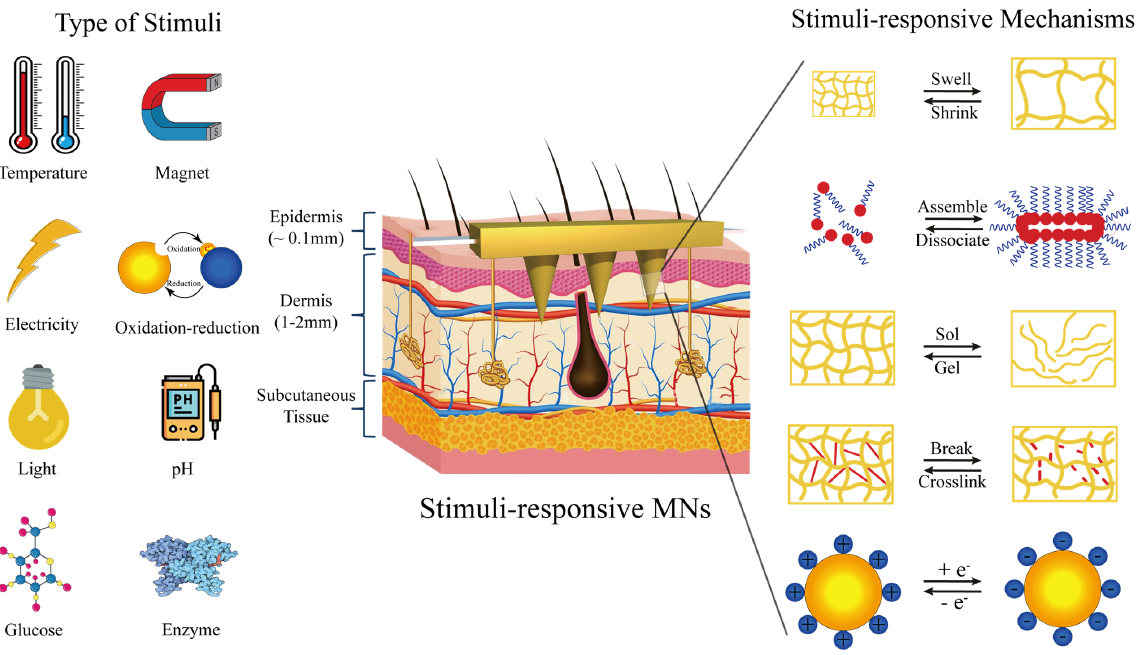
Figure 7. Types of stimulus response.